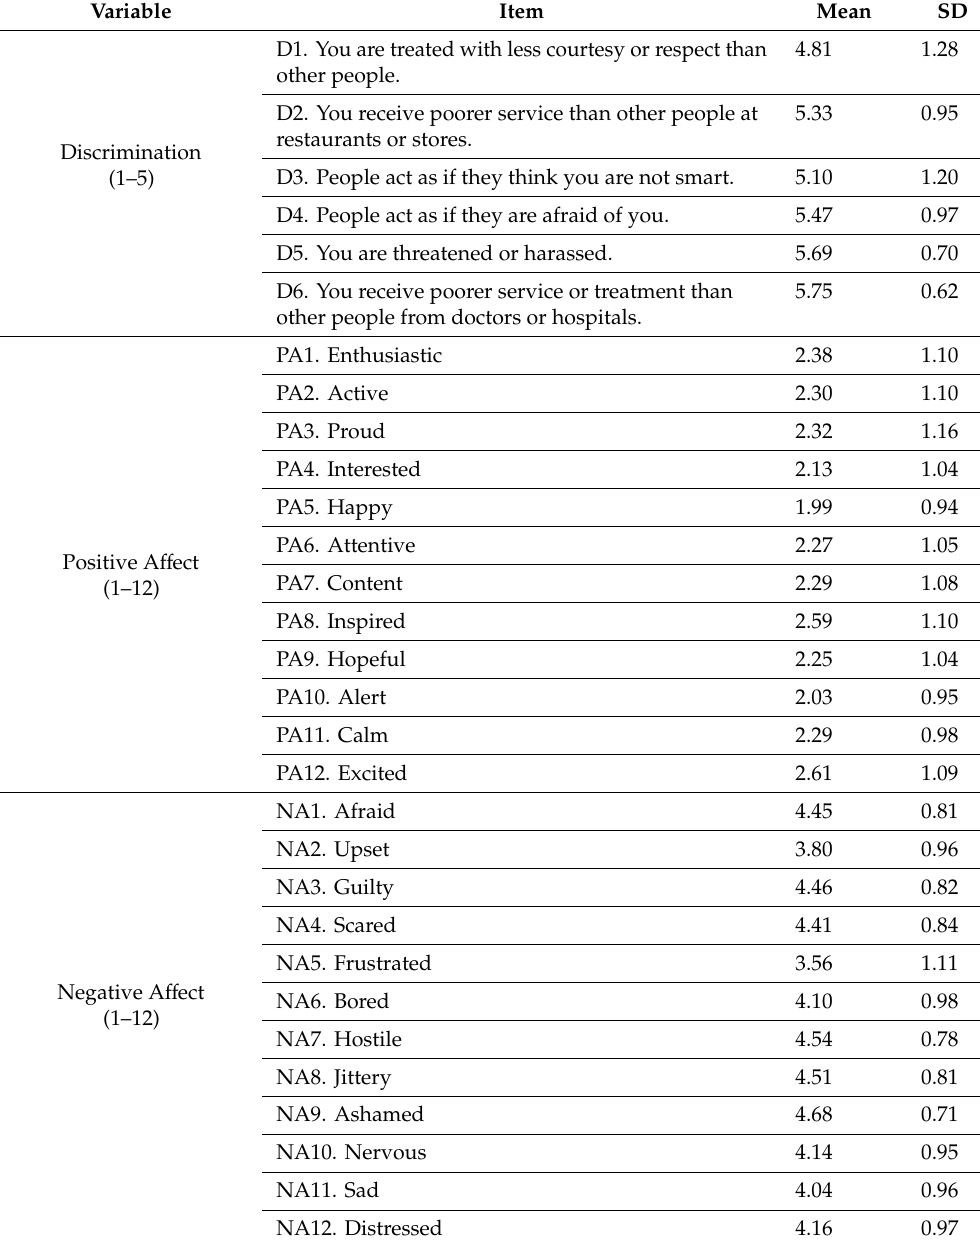
Table 2. Means (SD) for discrimination (D), positive a ff ect (PA), negative a ff ect (NA), presenteeism (P), and conscientiousness